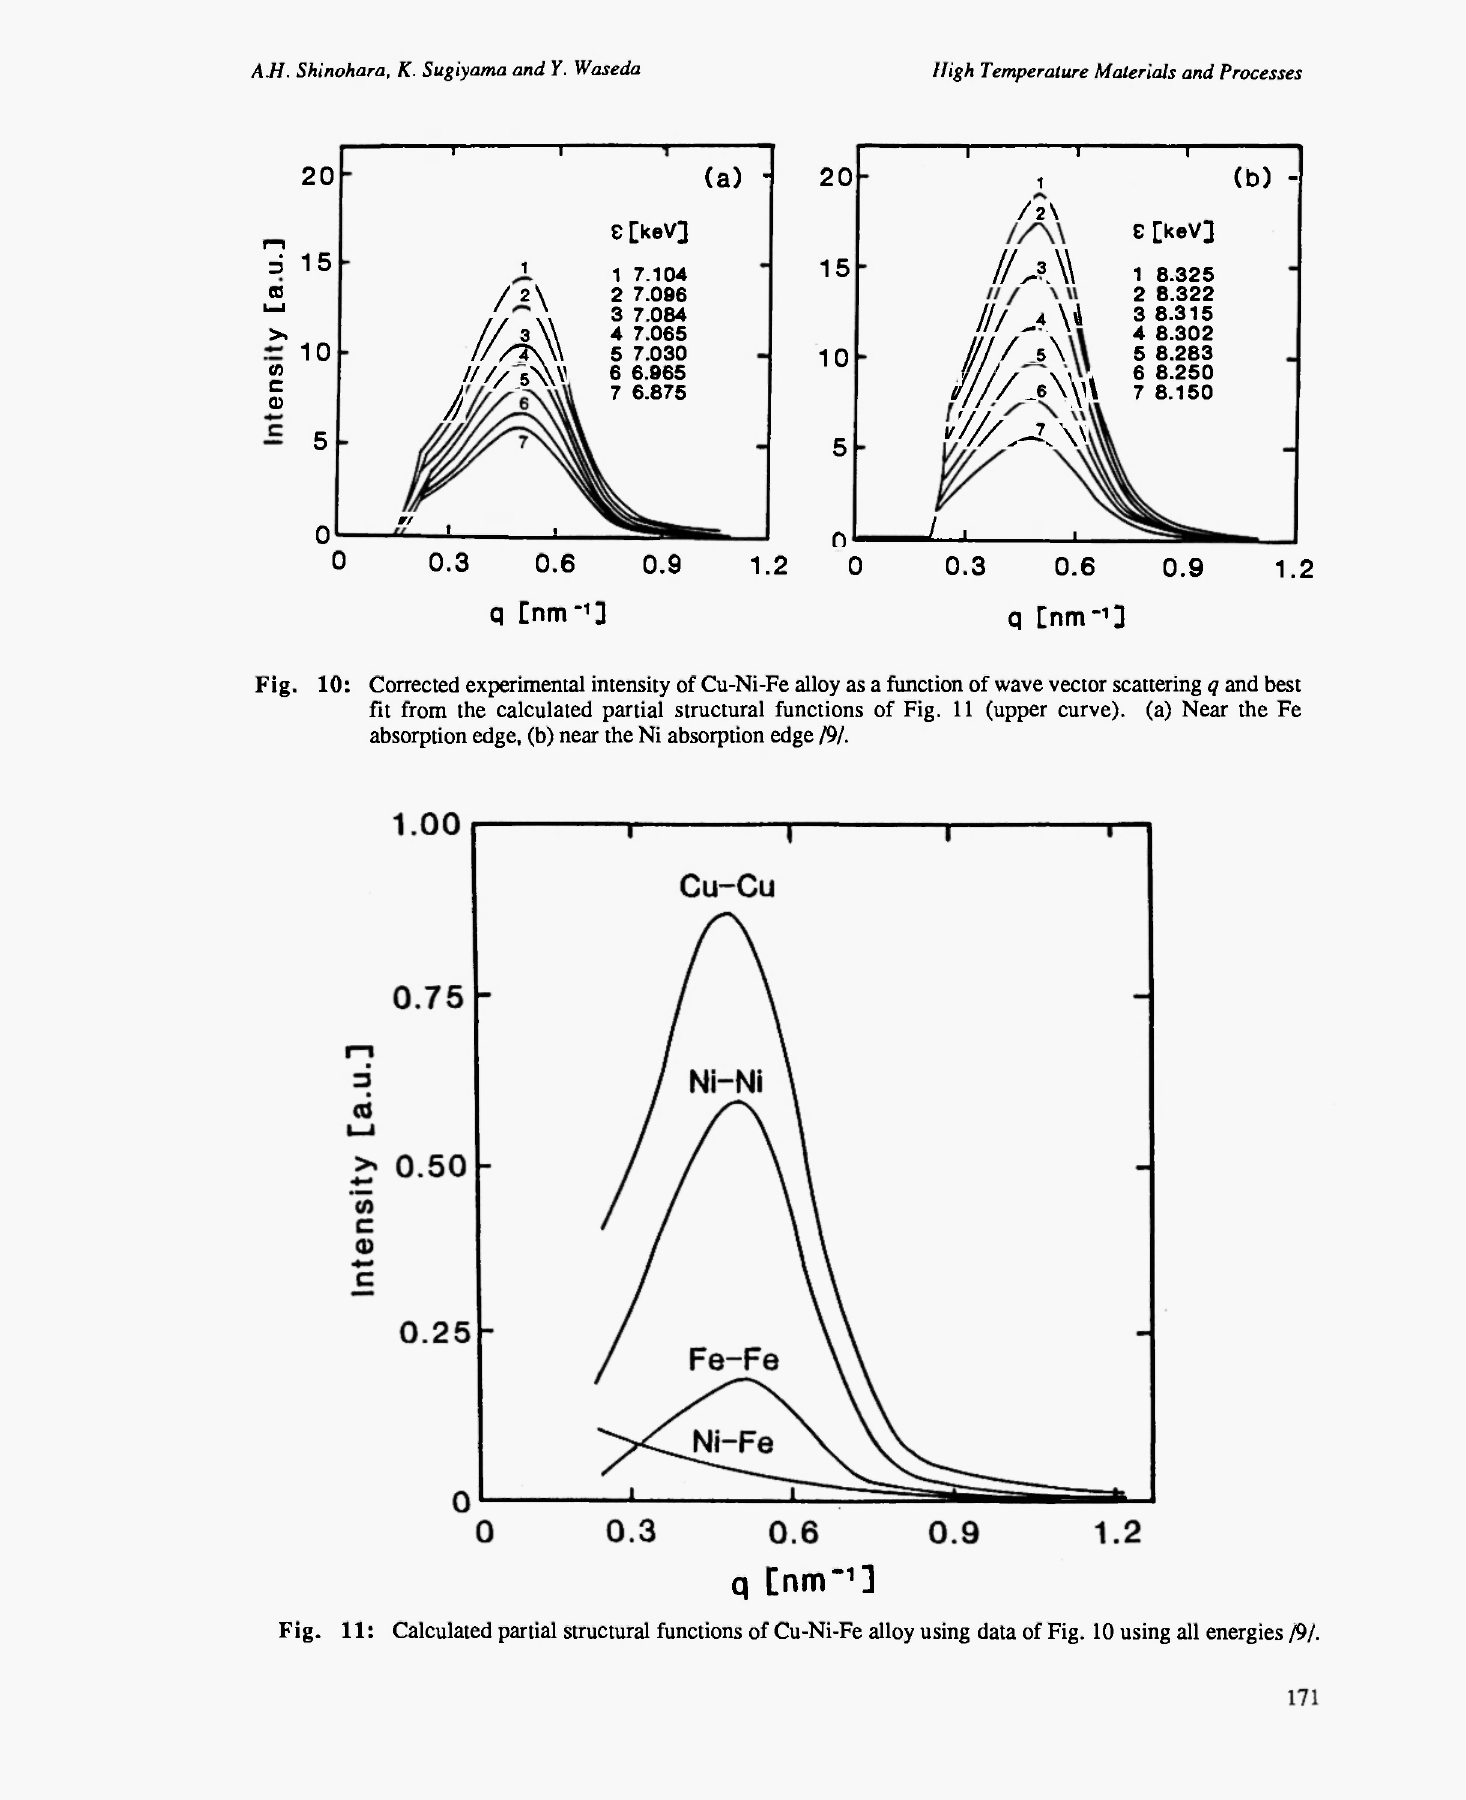
Fig. 11: Calculated partial structural functions of Cu-Ni-Fe alloy using data of Fig. 10 using all energies